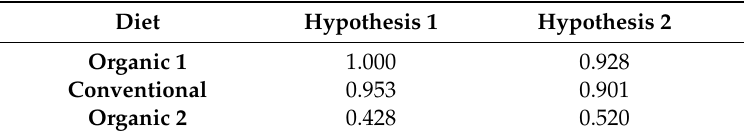
Table 6. Diagnostic frame of the scores obtained by each diet treatment in the two study hypotheses by means of the NSFDSS. The case with the ranking of criteria is named Hypothesis 1 and the “equal importance of criteria” hypothesis is called Hypothesis 2.